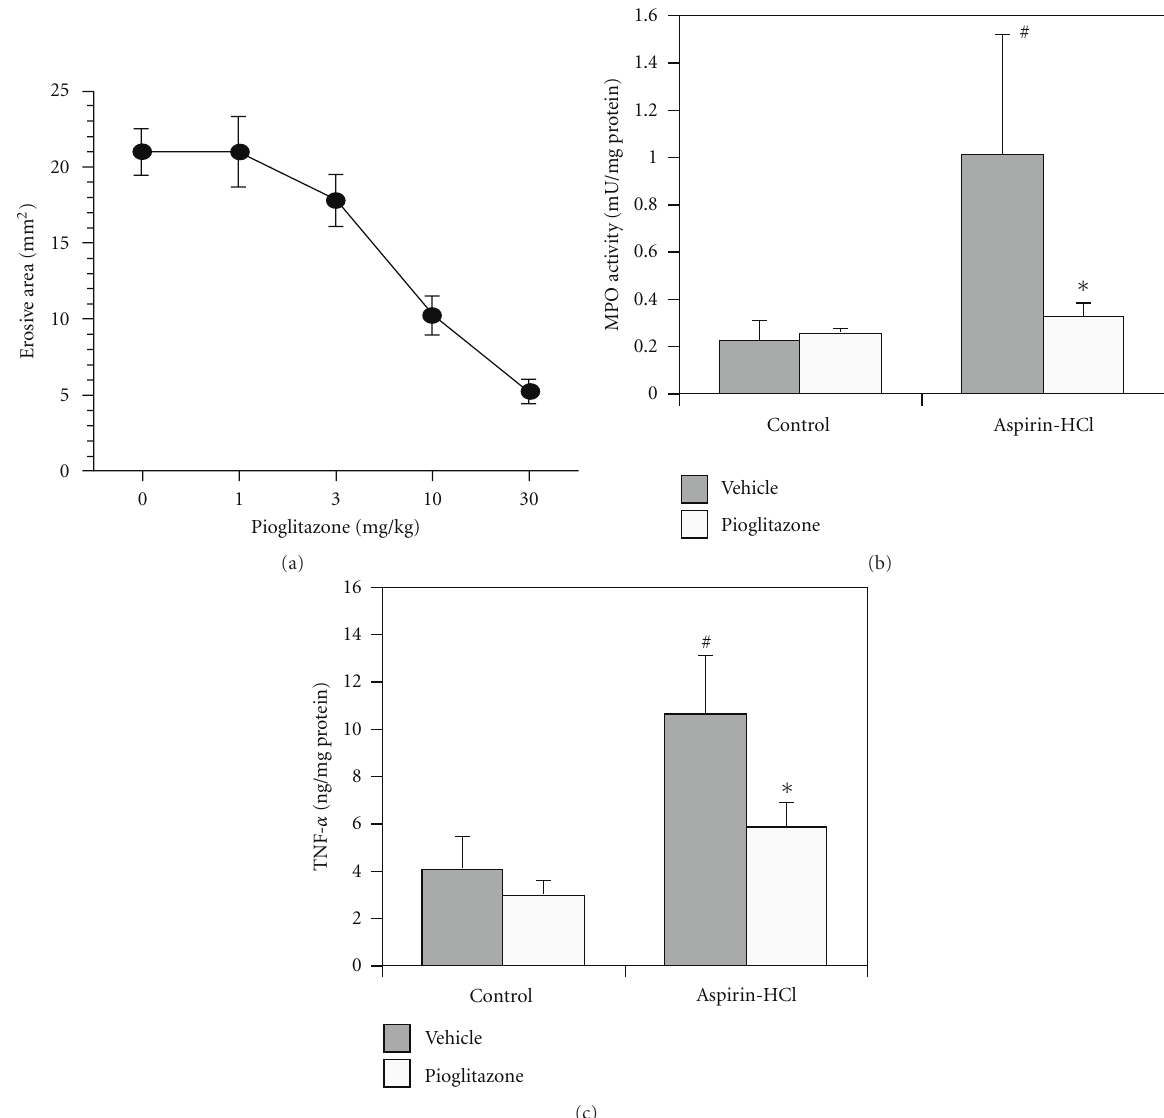
Figure 1: E ff ect of increasing doses of pioglitazone on acute gastric mucosal injury induced by aspirin-HCl in rats (a) The e ff ect of pioglitazone on tissue-associated myeloperoxidase (MPO) activity (b) and TNF- α content (c) induced by aspirin-HCl in the gastric mucosa. TNF- α content and MPO activity in the gastric mucosa increased after aspirin administration. This increase in TNF- α content and MPO activity was inhibited by pioglitazone